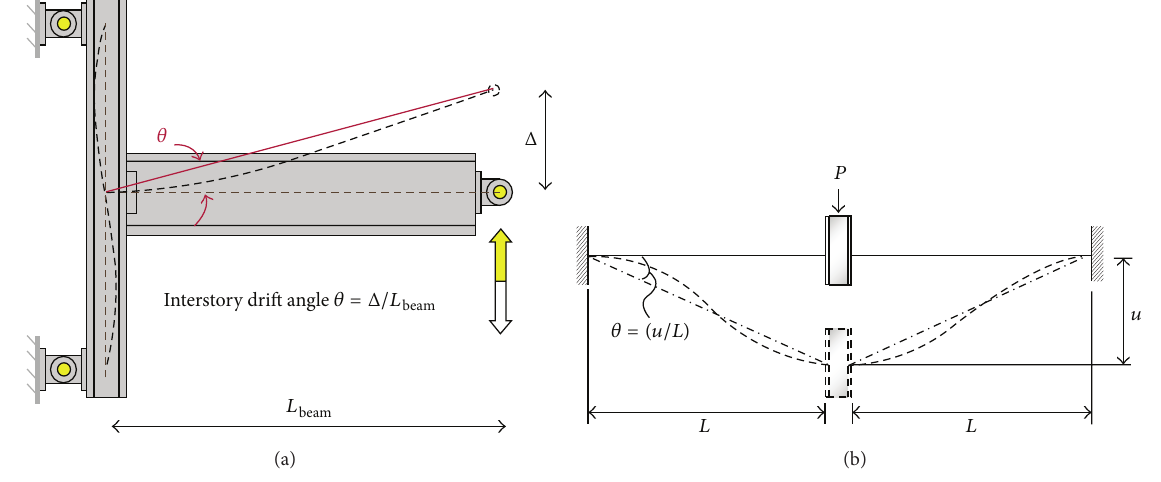
Figure 12: Definition of interstory drift angle (a) and connection rotation capacity (b).